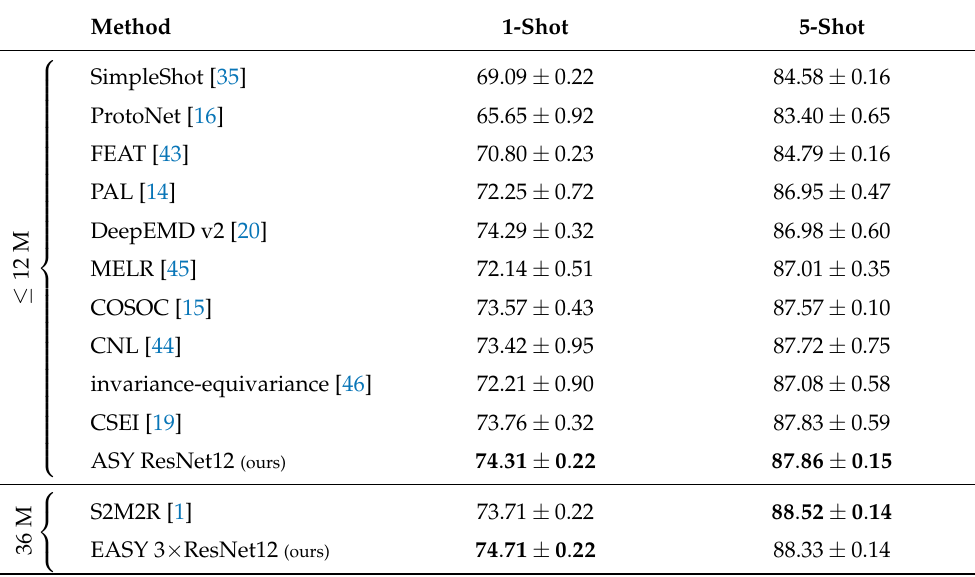
Table 2. The 1-shot and 5-shot accuracy of state-of-the-art methods and the proposed solution on TieredImageNet in the inductive setting.